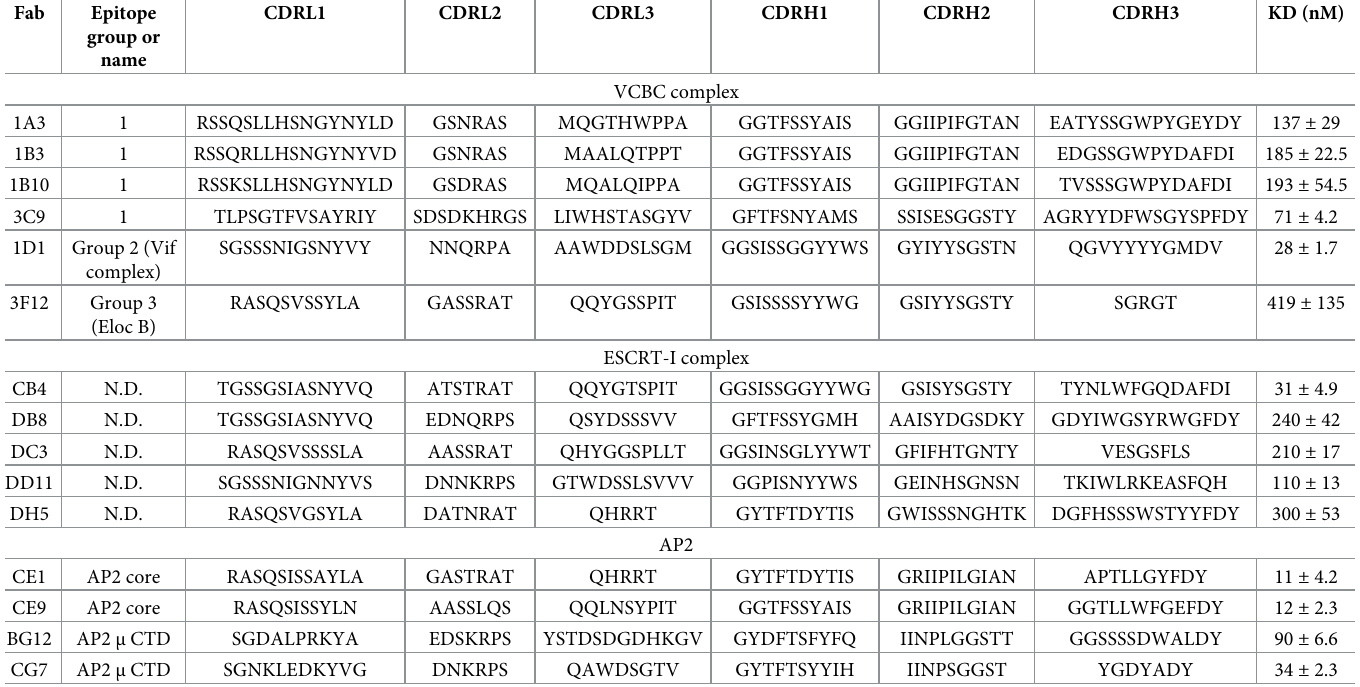
Table 1. Fab fragments identified. The sequence of the six complementarity determining regions (CDRs) and the dissociation constants of the Fabs identified in this study. N.D. indicates not